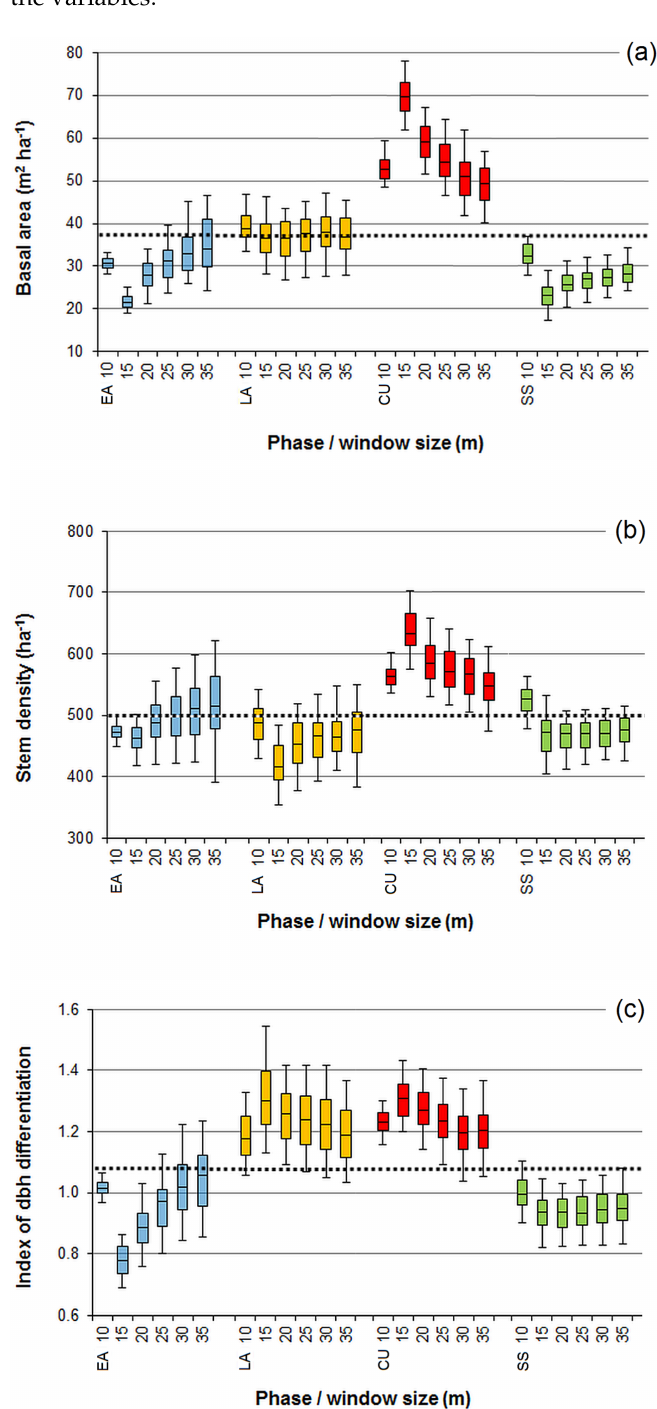
Figure 4. Basal area ( a ), stem density ( b ), and index of structural differentiation ( c ) in the stand patches assigned to the early accumulation (EA), late accumulation (LA), culmination (CU), and steady-state (SS) phases, depending on the diameter of the moving window (range 10–35 m). The bars, boxes, and whiskers illustrate the median, interquartile range, and 5th and 95th percentile values obtained from 100 simulations of a random tree distribution in the model stand (see Figure 2). The stand-level values are marked by the horizontal dotted